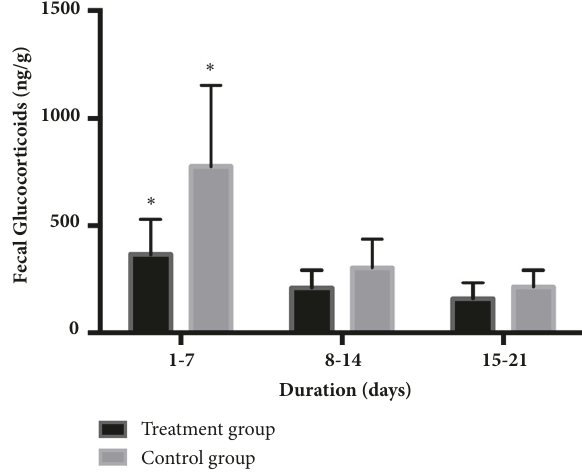
Figure 1: Comparing the number of times 80% of the piglets came to sow’s udder to suckle in the treatment group (exposed to AS sounds) and the control group (not exposed to AS sounds) in each lactating period (1-7, 8-14, and 15-21 days after parturition). a , b Statistical significance (P < 0.05) between groups.